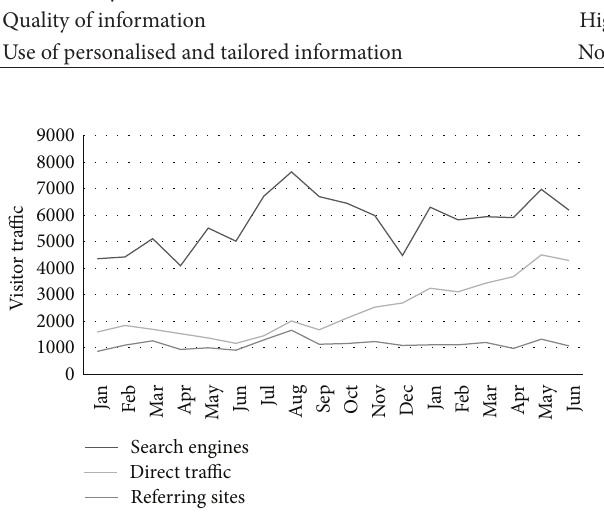
Figure 3: Ngala Healthy You, Healthy Baby app self-assessments during the first year of release according to perinatal stage.